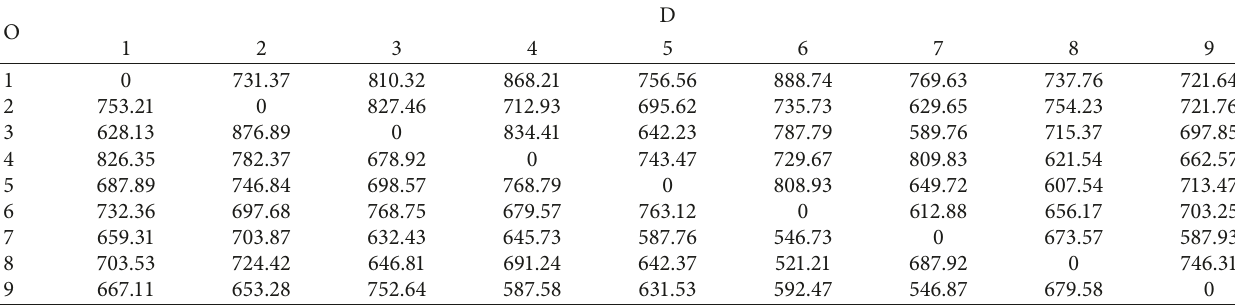
Table 1: The current travel OD of the Academy Street (person/h).